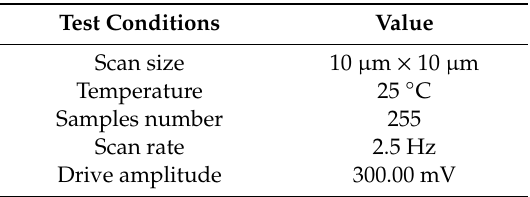
Table 2. Test conditions of atomic force microscope